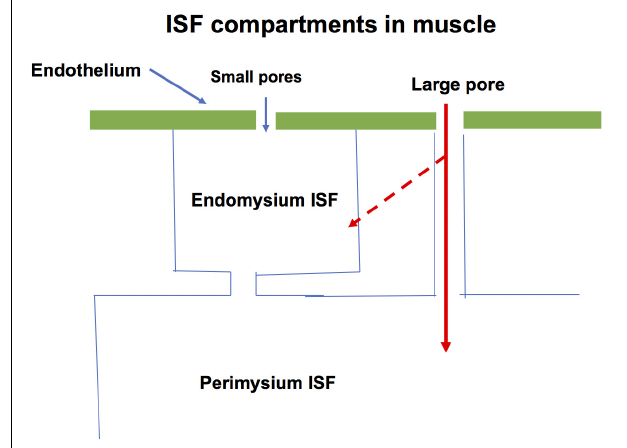
FIGURE 2 | A specific form of Model in Figure 1A used to describe water and solute exchange in skeletal muscle is shown. The endomysium is adjacent to the capillaries and is estimated to occupy one sixth of the interstitial fluid space. The bulk of the ISF is in the perimysium. During the transient exchanges investigated in this paper it is assumed that exchange across both the glycocalyx and large pore pathways mixes into the endomysium ISF (broken